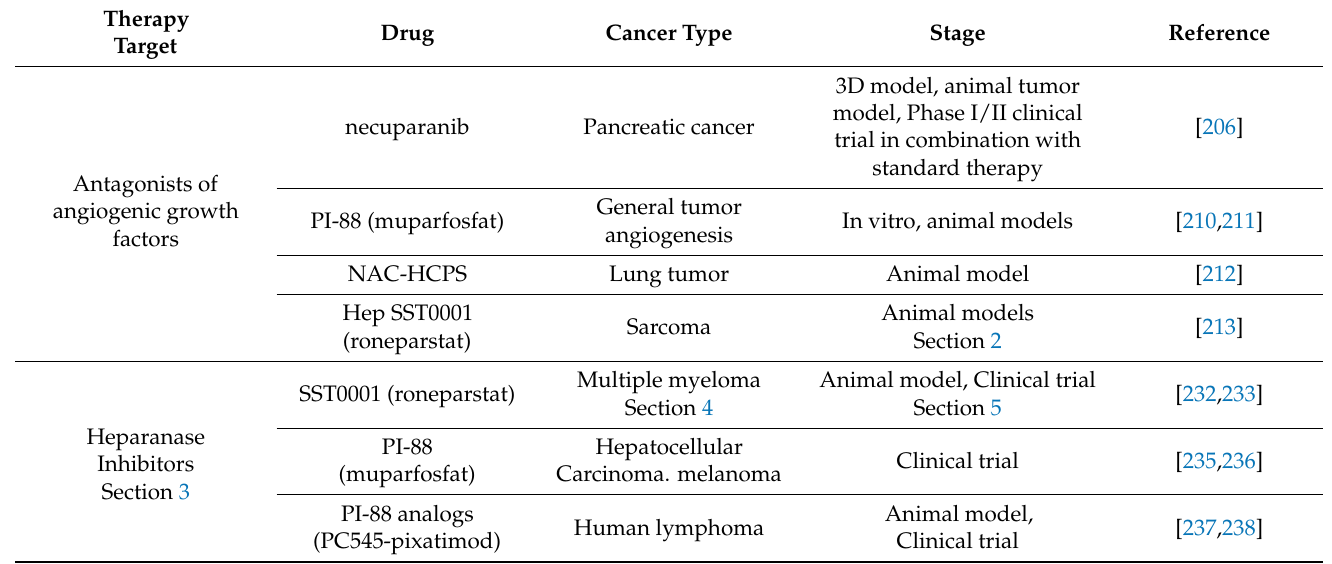
Table 3. Therapeutics targeting